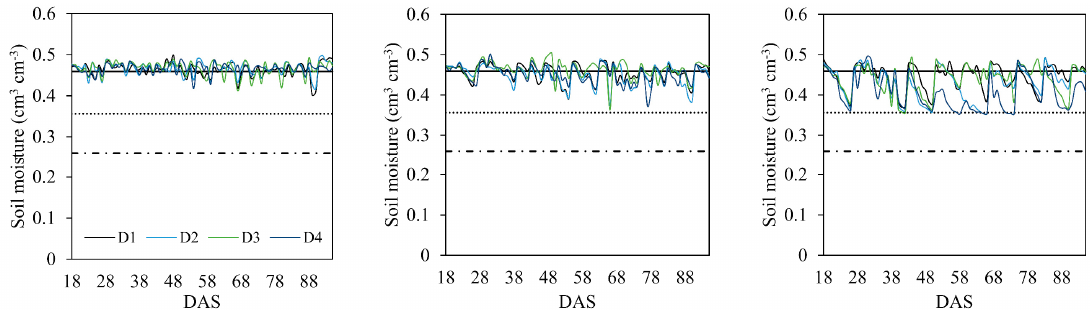
Figure 3. Variation of soil moisture in each treatment during the experiment. Continuous line (field capacity); Dotted line (management deficit); and Dashed line (permanent wilt point). Irrigation frequencies of one (F1), four (F2), and eight (F3) days. Planting densities of 20 (D1), 24 (D2), 28 (D3), and 30 (D4) plants per m 2 .